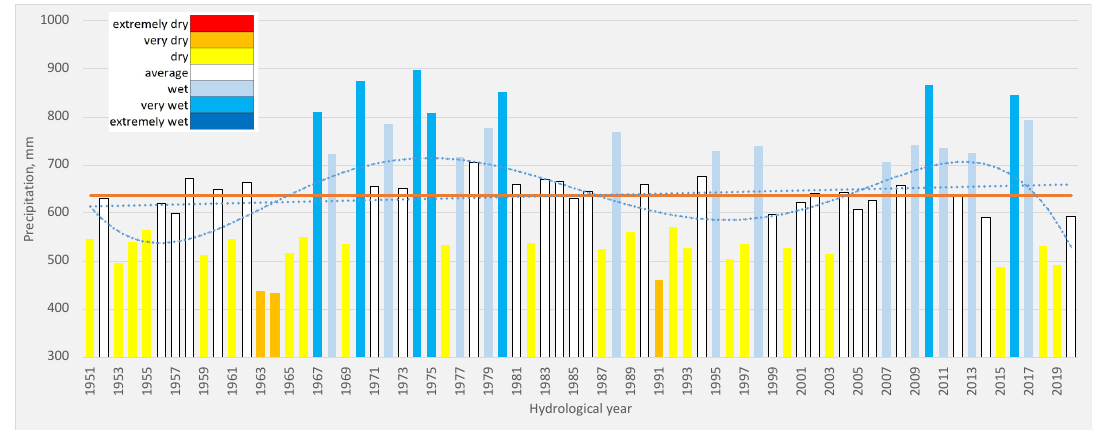
Figure 5. Annual precipitation at the Bia ł owie ż a climatic station into summer and winter half-years (measured in hydrological years).